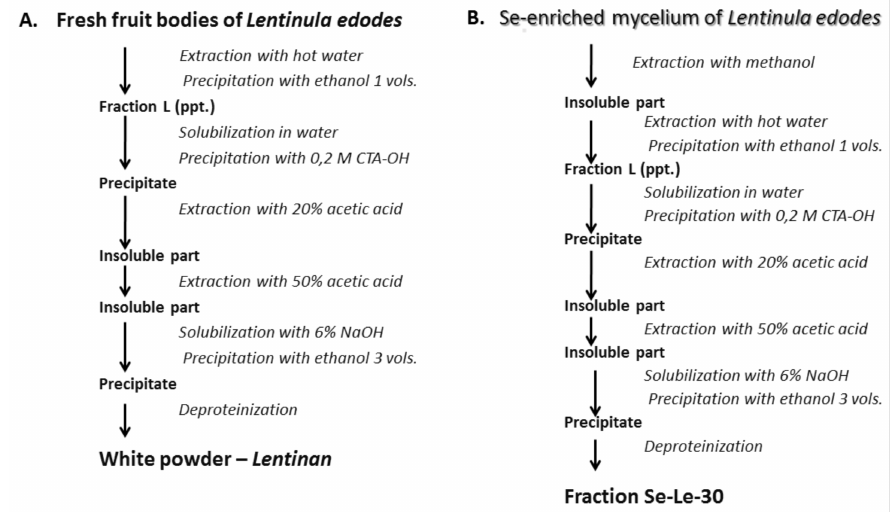
Figure 7. Isolation methods. ( A ) Chihara’s method of isolating lentinan. ( B ) Method modified for isolation of Se-enriched lentinan analogue ( Se-Le-30